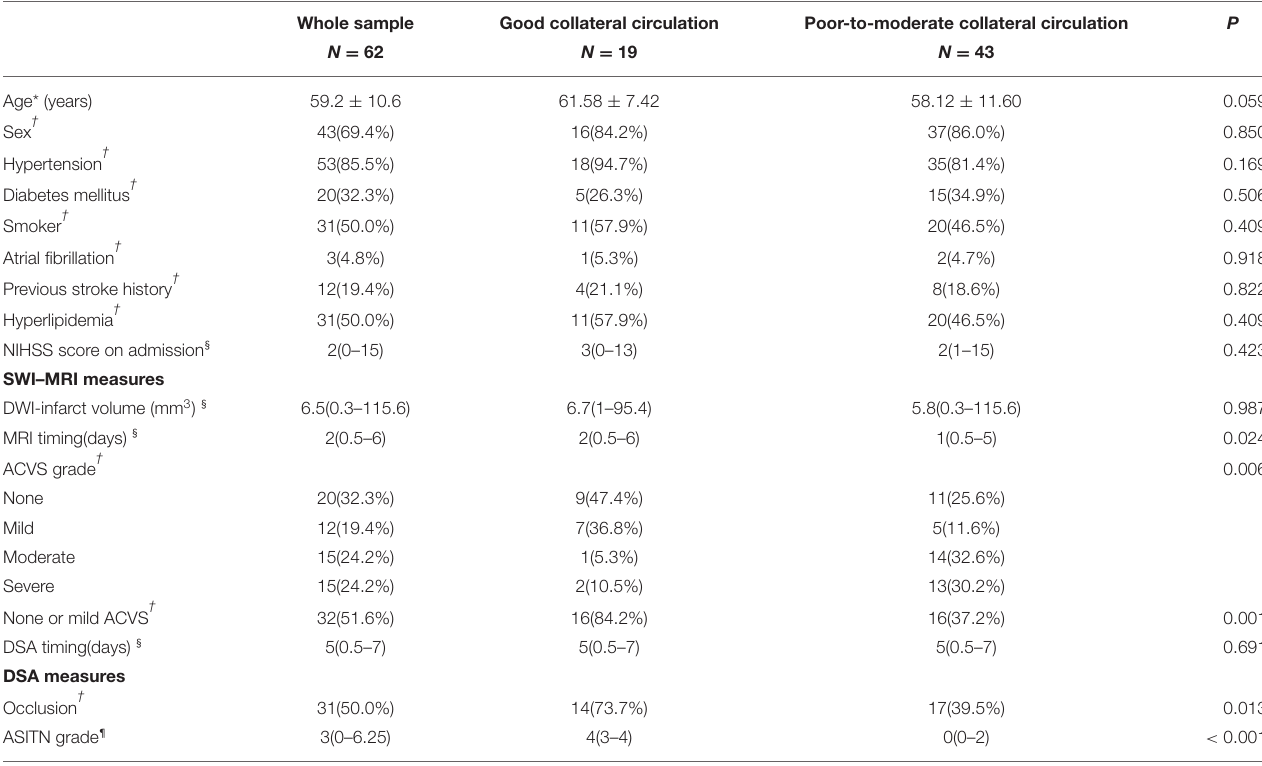
TABLE 1 | Comparisons of clinical variables and neuroimaging variables between patients with a DSA-confirmed good collateral circulation or not. Whole sample Good collateral circulation Poor-to-moderate collateral